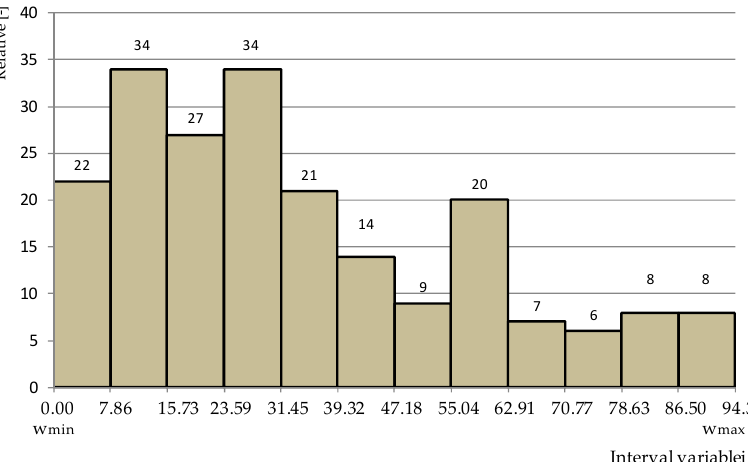
Figure 9. Histogram of relative error counts of the percentage fit of the multiple regression model of friction pad weight wear to test results.